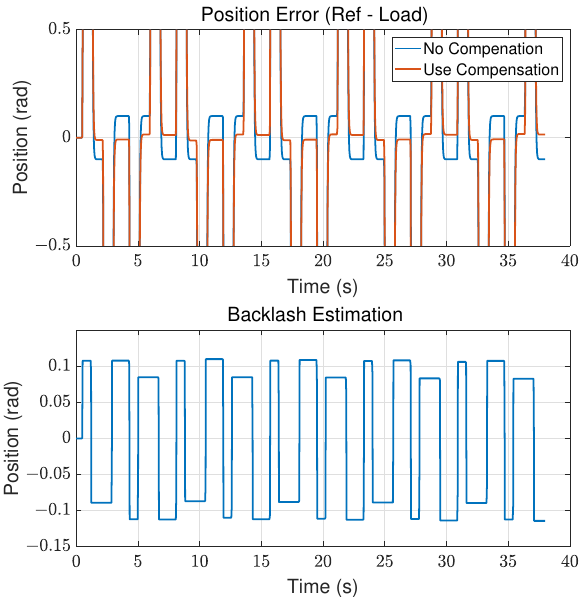
Figure 10. Upper : position error comparison. Lower : backlash distance